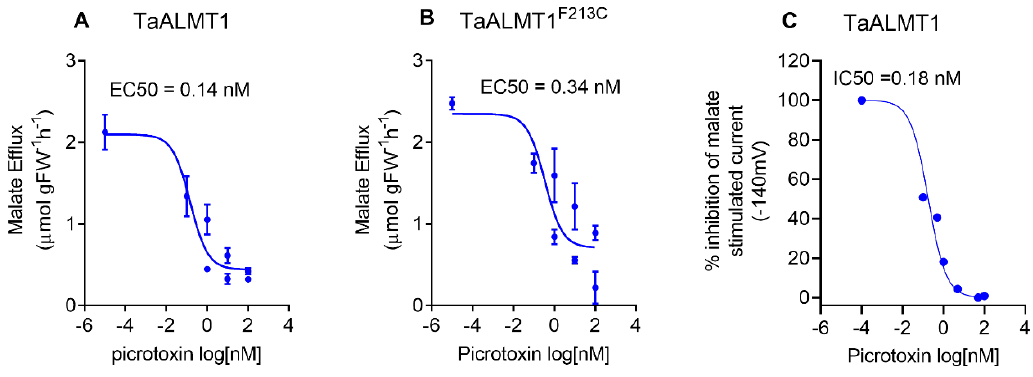
Figure 4. ( A , B ) Dose–response curves for picrotoxin inhibition of malate efflux (pH 7.5) from tobacco BY2 cells expressing TaALMT1 or the GABA-insensitive mutant ( TaALMT1 F213C ). ( C ) Inhibition of inward current (anion efflux) expressed as % inhibition from Xenopus oocytes expressing TaALMT1 . Oocytes were preloaded with malate. Controls (water injected) were subtracted from the TaALMT1 expressing oocytes. Dose response calculated from n = 3 for tobacco BY2 cells and n = 5 for Xenopus oocytes.